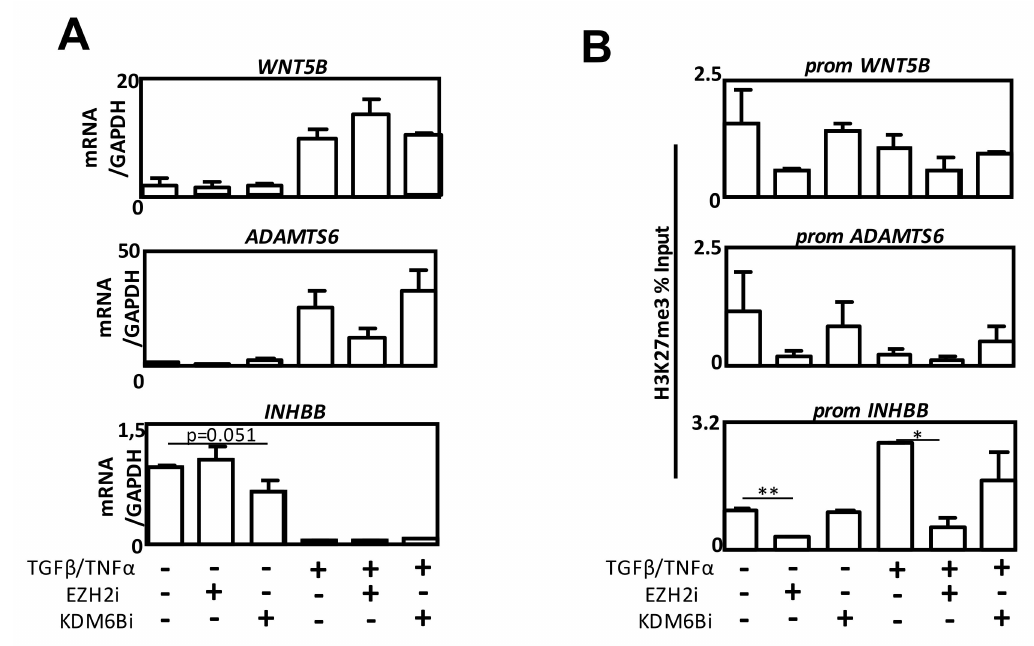
Figure 6. The e ff ect of EZH2 and KDM6B inhibition on INHBB, WNT5B, or ADAMTS6 expression. ( A ) Quantification of WNT5B, ADAMTS6 , or INHBB expression using RT-qPCR in A549 cells treated with TGF β / TNF α and / or EZH2i or KDM6Bi. ( B ) Quantification of H3K27me3 content in WNT5B , EZH2 , or KDM6B promoters using ChIP, in A549 cells treated with TGF β / TNF α and / or EZH2i or TGF β / TNF α and / or KDM6Bi. * = 0.01 < p < 0.05; ** = 0.005 < p <